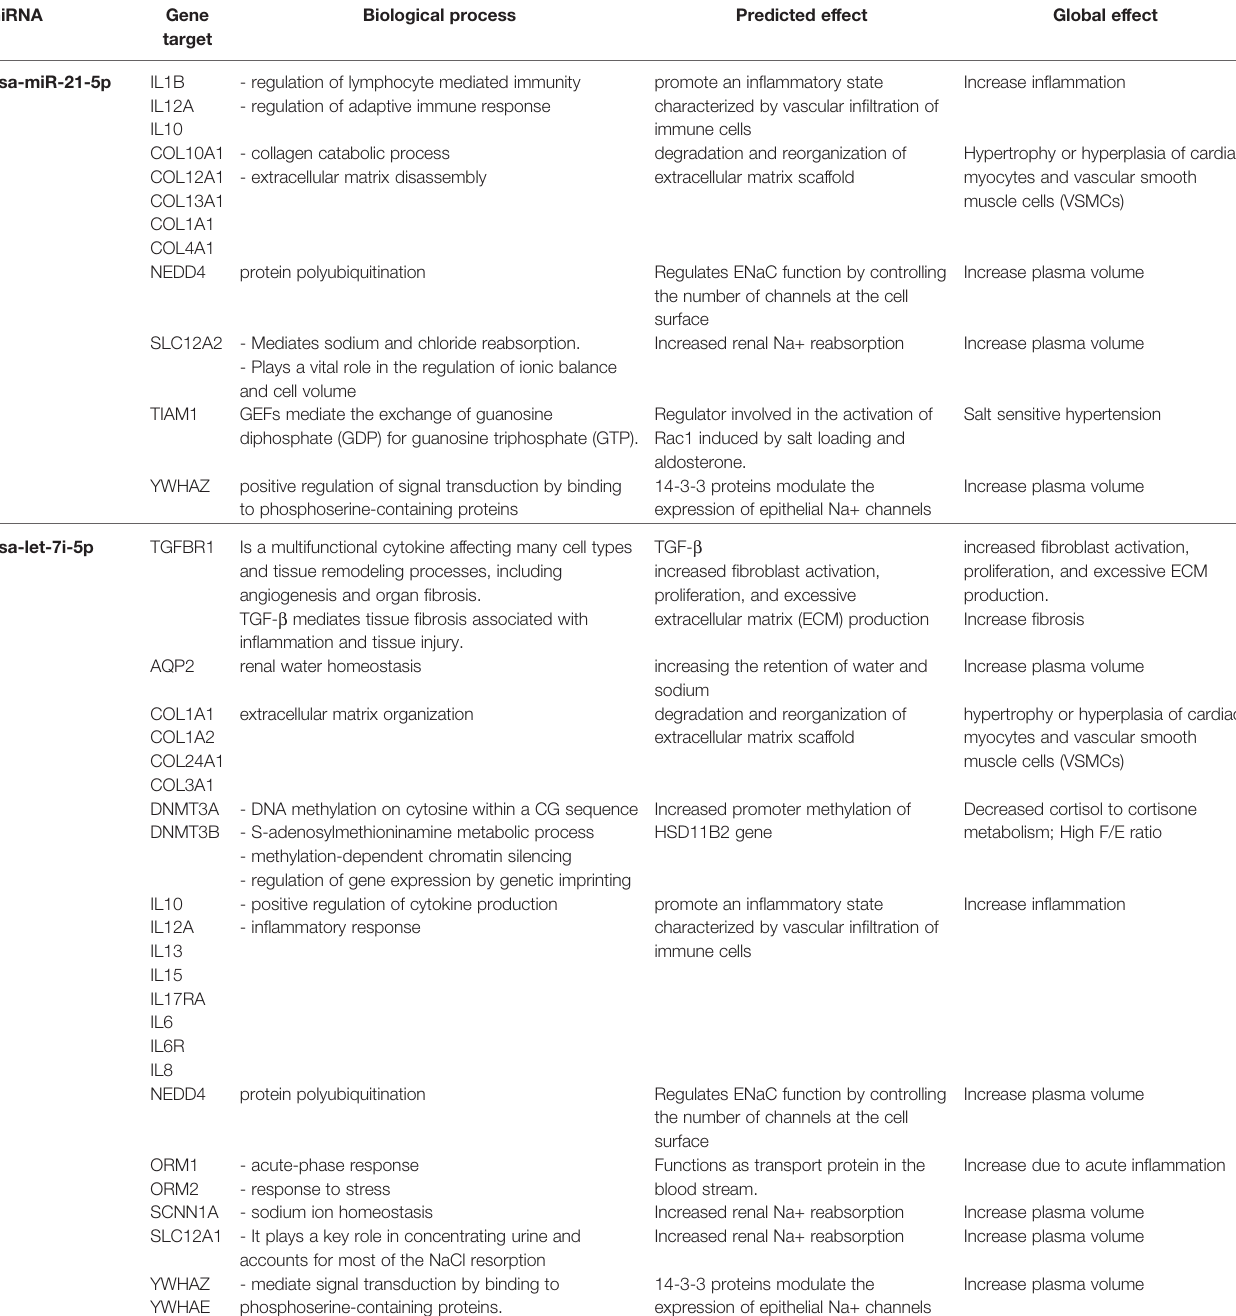
TABLE 6 | Target genes of miR-21-5p and Let-7i-5p, biological process associate and its predicted renal and global effect.